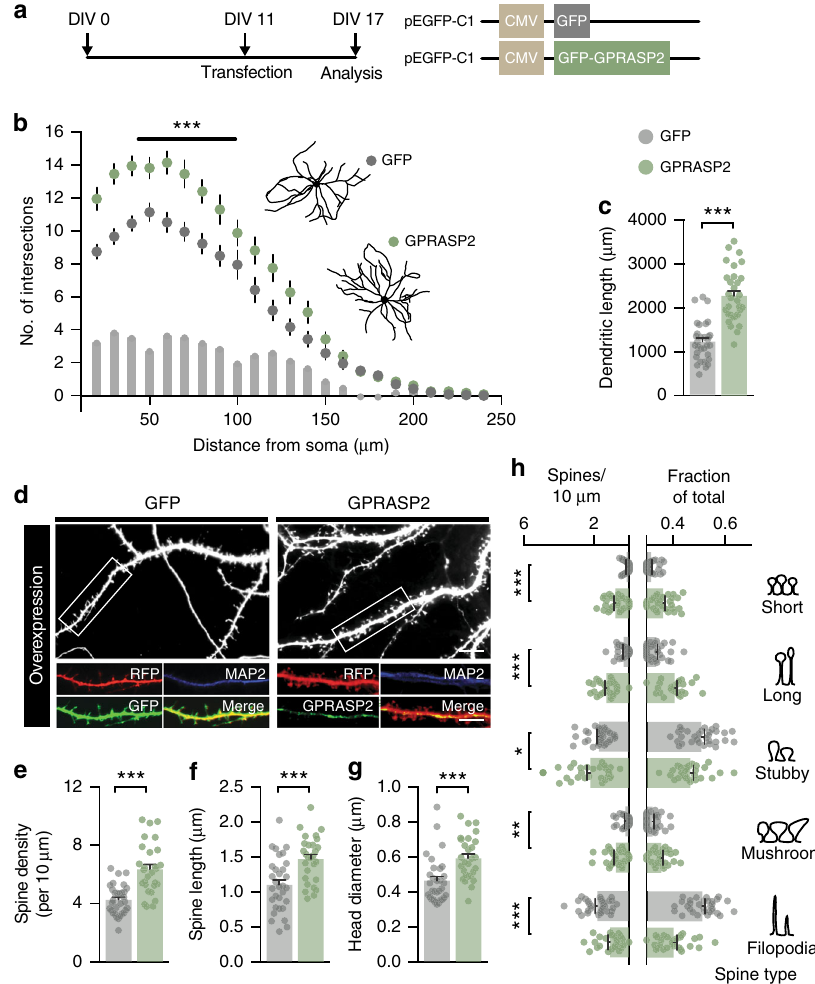
Fig. 5 GPRASP2 overexpression induces cell autonomous increased in spine density and spine maturation. a Cultured hippocampal neurons were transfected with GFP alone or GFP-GPRASP2 at DIV11 and analysed at DIV17. b Sholl analysis reveals increased dendritic complexity in GPRASP2- overexpressing neurons compared with GFP controls; GFP n = 31, GPRASP2 n = 31, from three independent preparations; two-way repeated measures ANOVA. c GPRASP2 overexpression increases total dendritic length; GFP n = 31, GPRASP2 n = 31, from three independent preparations; two-tailed t -test. d – g GPRASP2 overexpression leads to increased spine density ( e ), increased spine length diameter ( f ) and increased spine head diameter ( f ); GFP n =